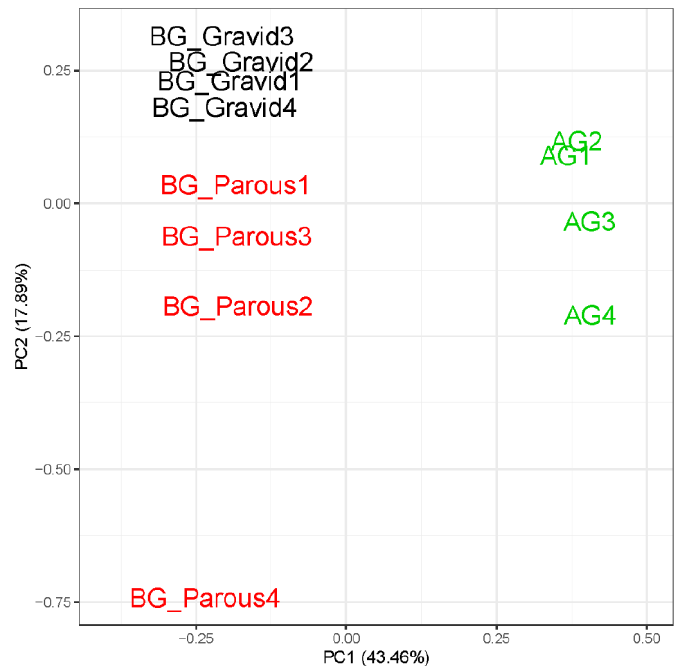
Figure 2. Principal component analysis (PCA) of sample-to-sample variation in gene expression profile at 12,710 genes for below-ground females (BG1) that are parous and gravid as well as above-ground females (AG2) that are nulliparous.